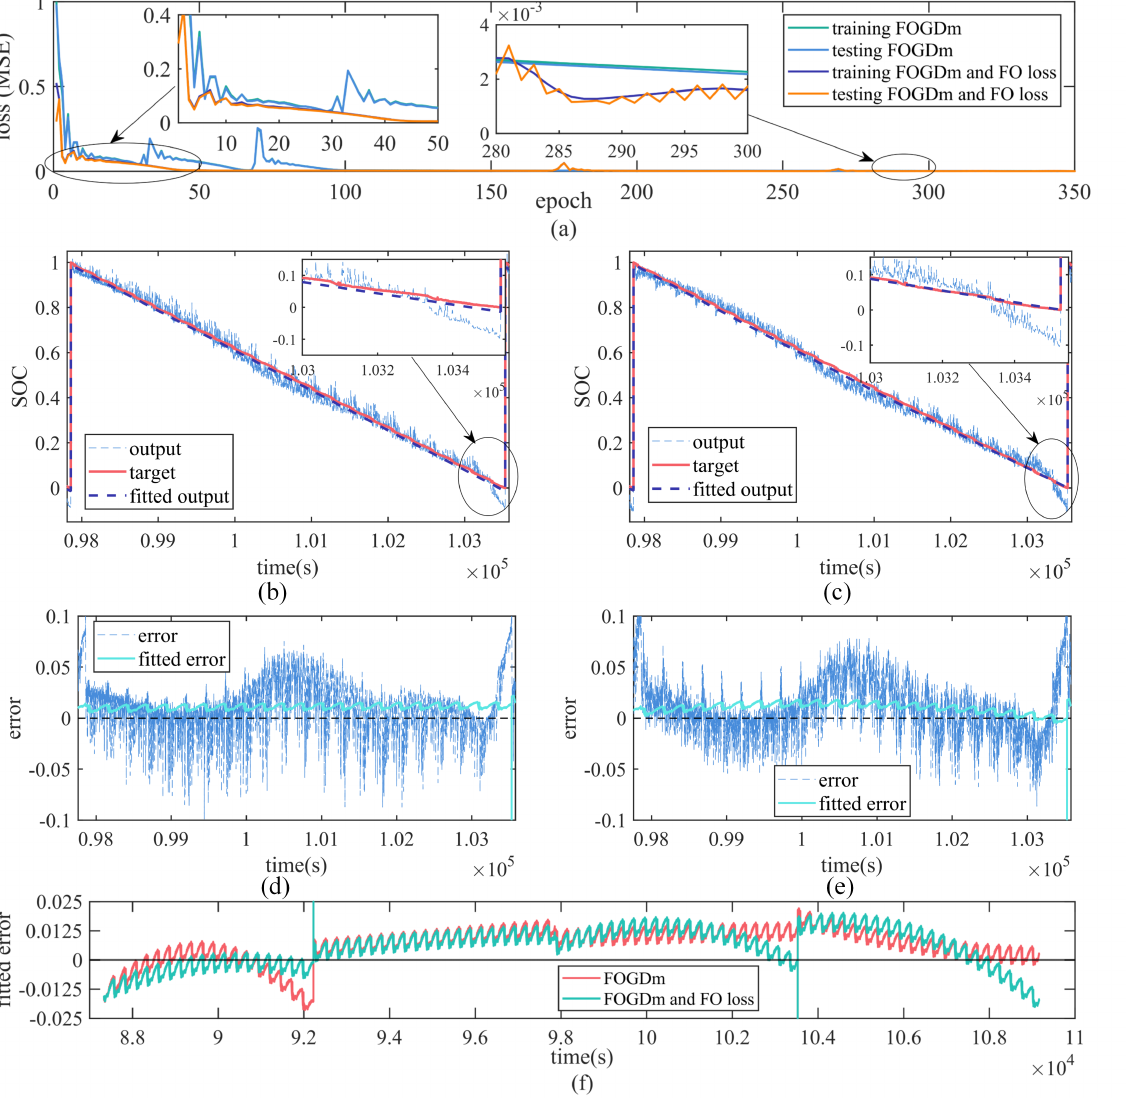
Figure 12. Experiment results of fPIRNN with FOGDm and fPIRNN with FOGDm and FO loss. ( a ) training and testing loss, ( b ) output SOC with FOGDm, ( c ) output SOC with FOGDm and FO loss, ( d ) estimated error with FOGDm, ( e ) estimated error with FOGDm and FO loss, and ( f ) comparison of fitted